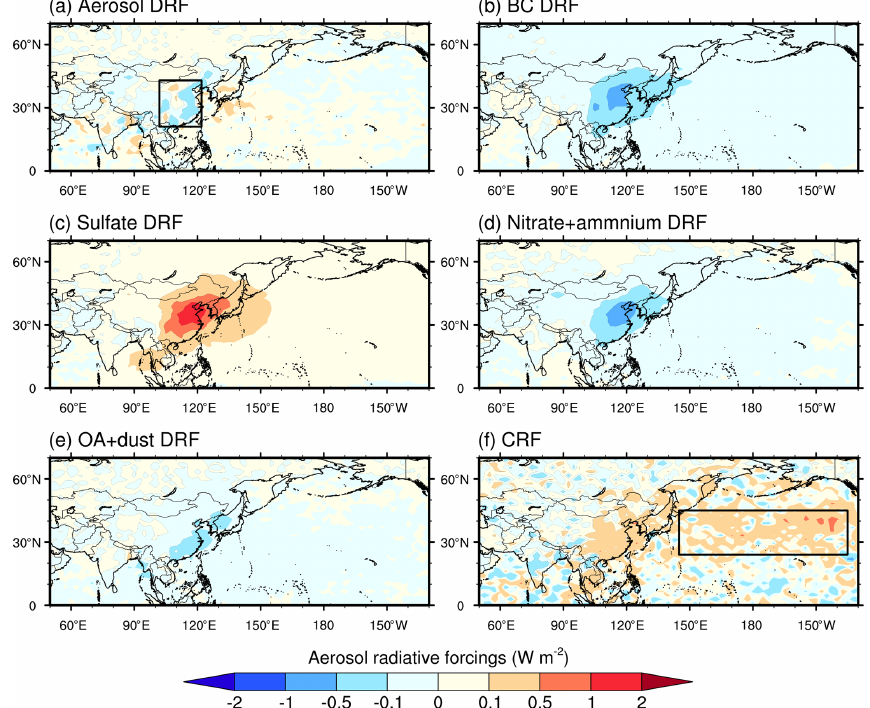
Figure 5. Map of DRF from total aerosols (a) , BC (b) , sulfate (c) , nitrate + ammonium (d) , OA + dust (e) , and aerosol-induced CRF (f) . The CRF values have been scaled by a constant factor of 5.4. Two regions of interest, eastern China and the northern Pacific, are marked in Fig. 6a and f with black boxes. DRF: direct radiative forcing; CRF: cloud radiative forcing. BC: black carbon; OA: organic